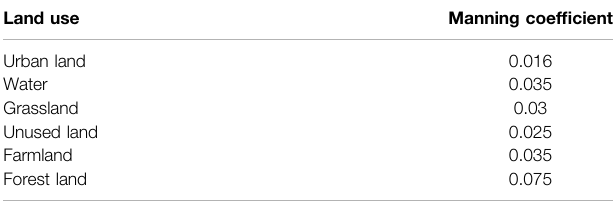
TABLE 1 | Manning coef fi